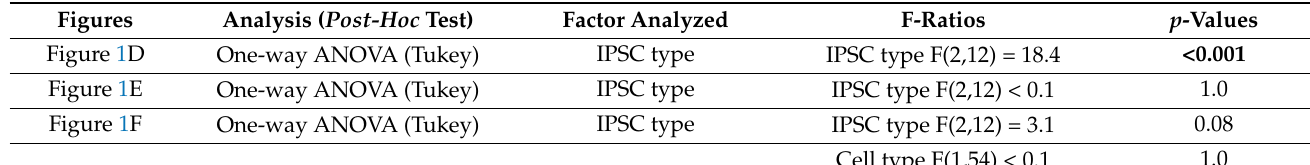
Table 1. Summary of statistical analysis.